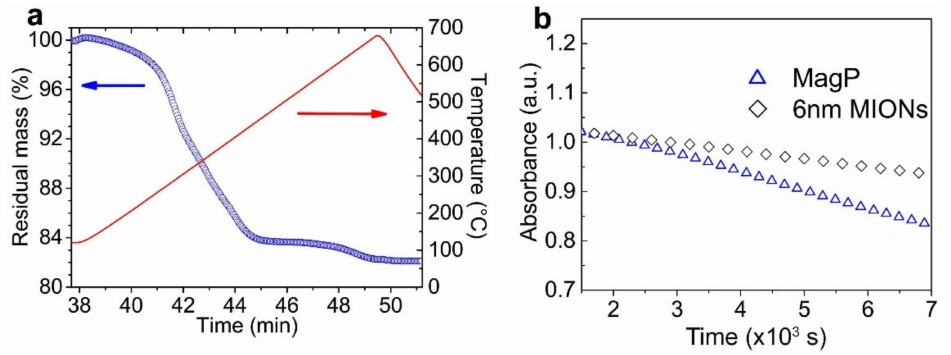
Figure 3. ( a ) Thermogravimetric analysis for the MagP MIONs; ( b ) magnetophoretic response of the MagP MIONs compared to samples composed of small magnetic nanocrystals with low Ms (~35 emu/g).